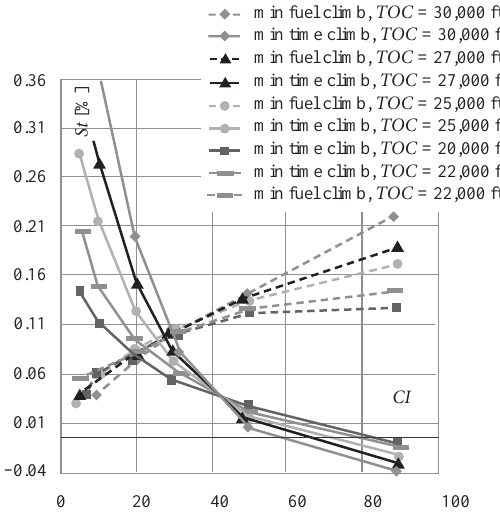
Fig. 6. Determination of the range of use of minimum costs climb technique, m c 1 = 41,000